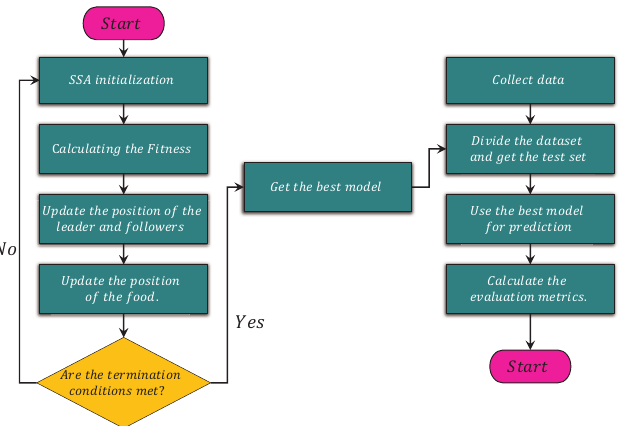
Figure 4. Flowchart of SSA optimization for hyperparameters of XGBoost.